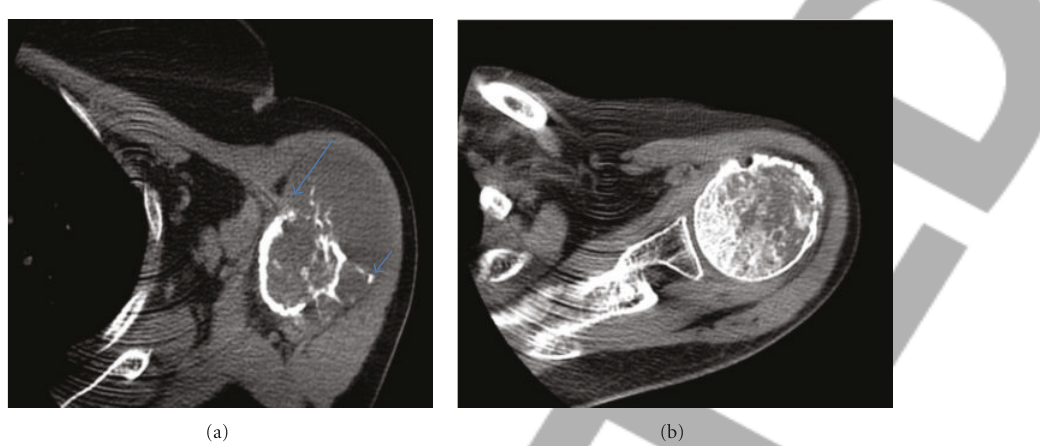
Figure 4: Axial CT images show osteolytic, expansile lesion causing endosteal scalloping with thinning of cortex. Break in the bony cortex at few places (large arrow) with calcific specks seen in soft tissue (small arrow).